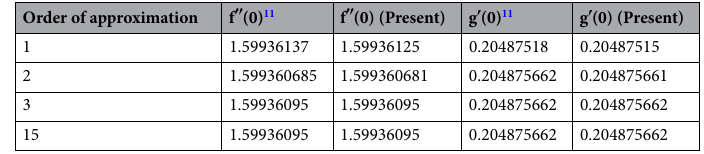
Table 3. Comparison of the current work.